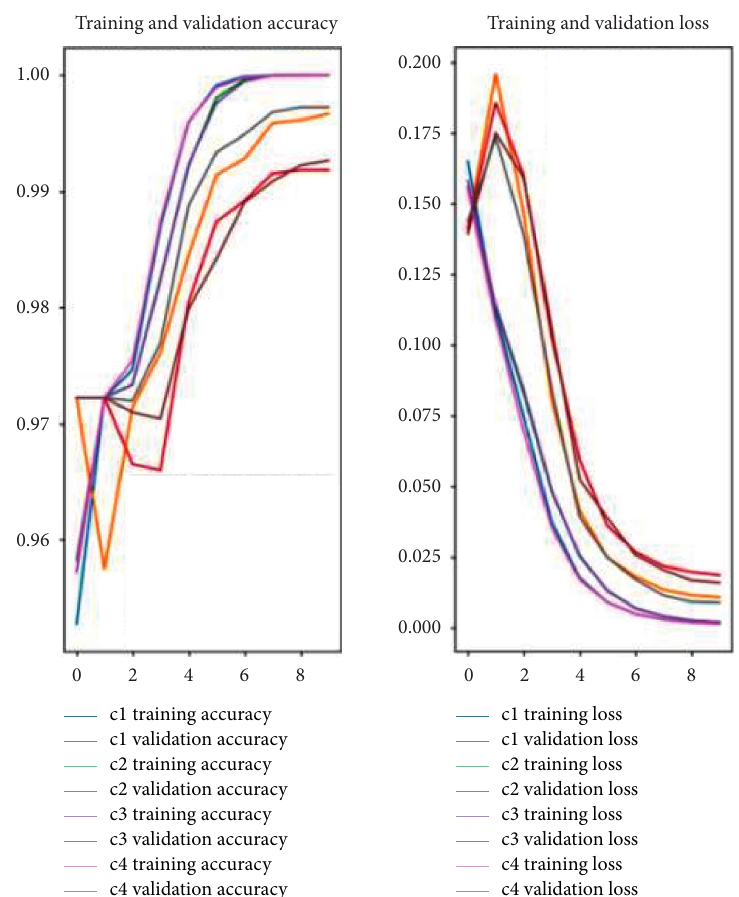
Figure 8: Curve of accuracy and loss value on ZhengFang